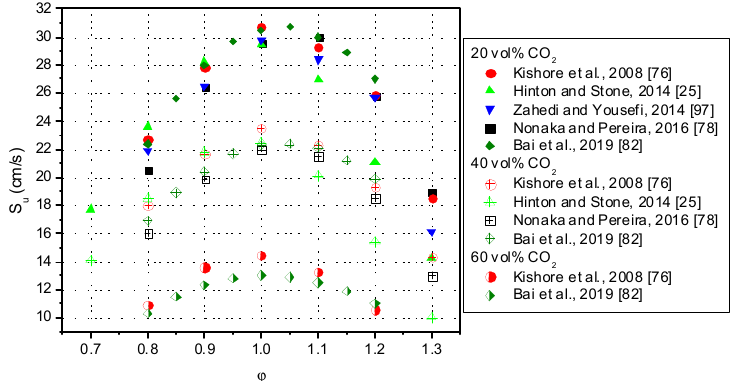
Figure 3. Variation of the experimental laminar burning velocities of biogas-air mixtures with various equivalence ratios, at different CO 2 contents and standard initial conditions.